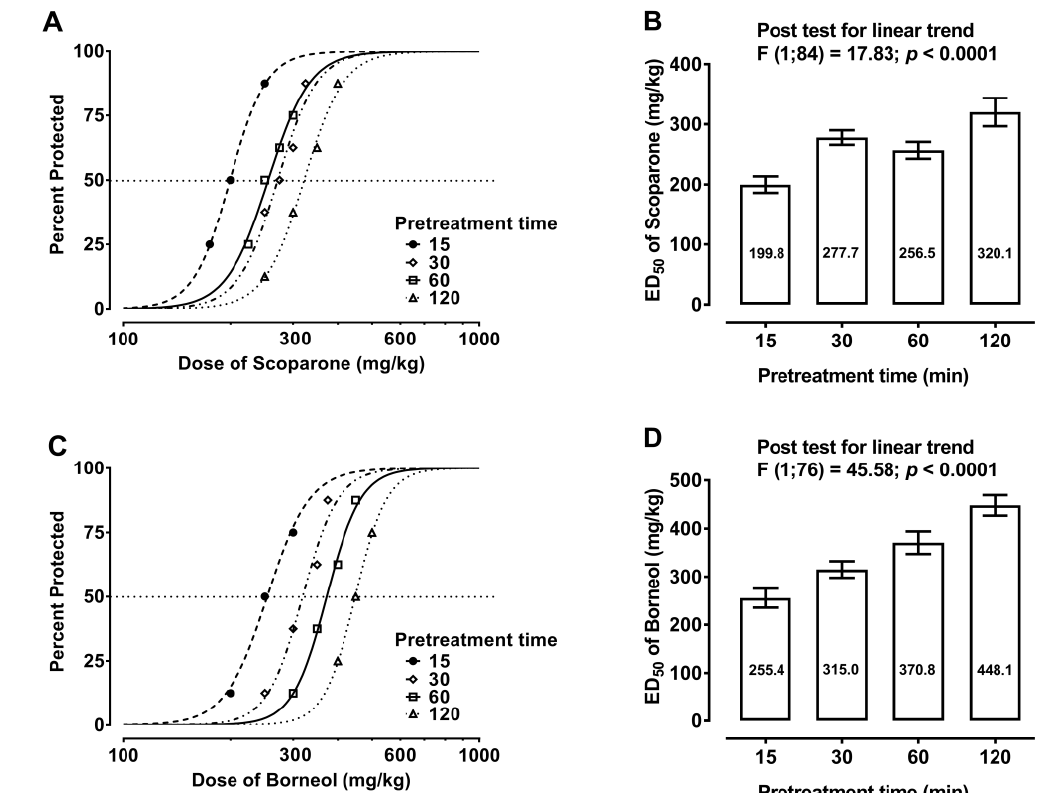
Figure 2. Time course of the anticonvulsant effects of scoparone and borneol in the mouse MES model. ( A , C ) Time course and dose–response relationship curves for scoparone and borneol administered systemically (i.p.) in the mouse MES model. The dotted line indicates the approx. ED 50 values for scoparone and borneol, respectively. ( B , D ) Columns represent the ED 50 values for scoparone and borneol when administered i.p. at various pretreatment times.